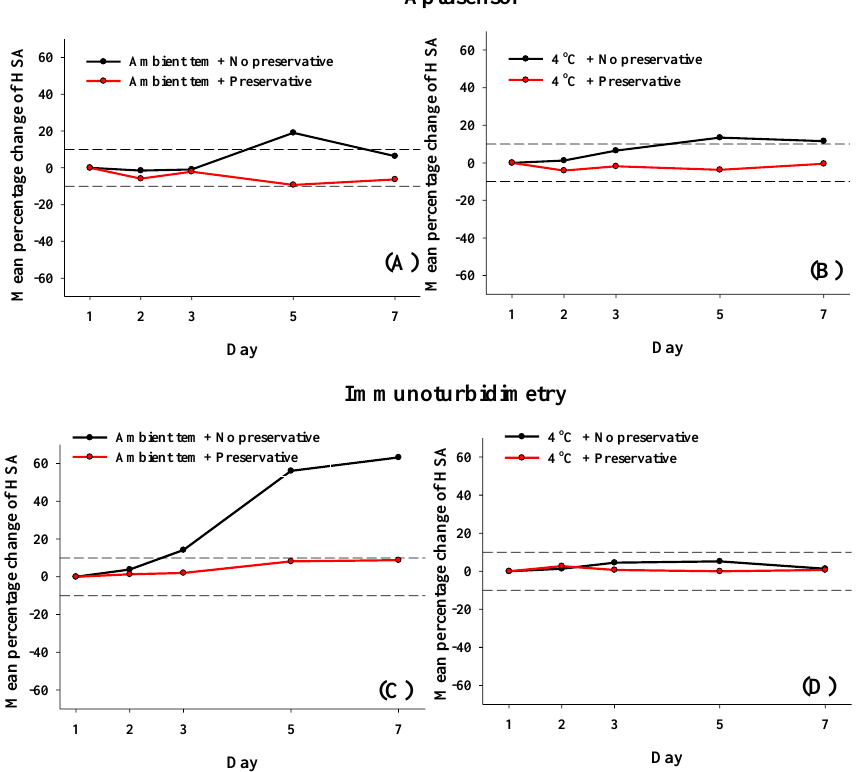
Figure 6. Mean percentage change in microalbumin analyzed by GO-based fluorescent detection ( A , B ) and immunoturbidimetry ( C , D ) with and without 2% ( w / v ) boric acid over a short term (1, 2, 3, 5 and 7 d). Dashed lines indicate ±10% change from the initial day 0 value.